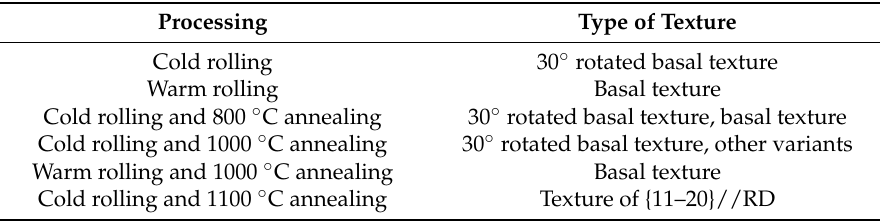
Table 1. Texture characteristics under different